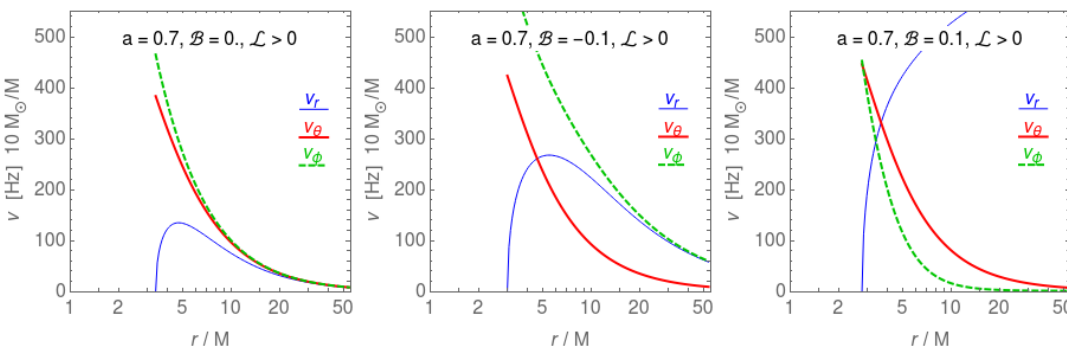
Figure 10. Radial profiles of the frequencies of small harmonic oscillations ν θ , ν r and ν φ of charged particle orbiting a Kerr black hole of mass M = 10 M characterized by the parameter